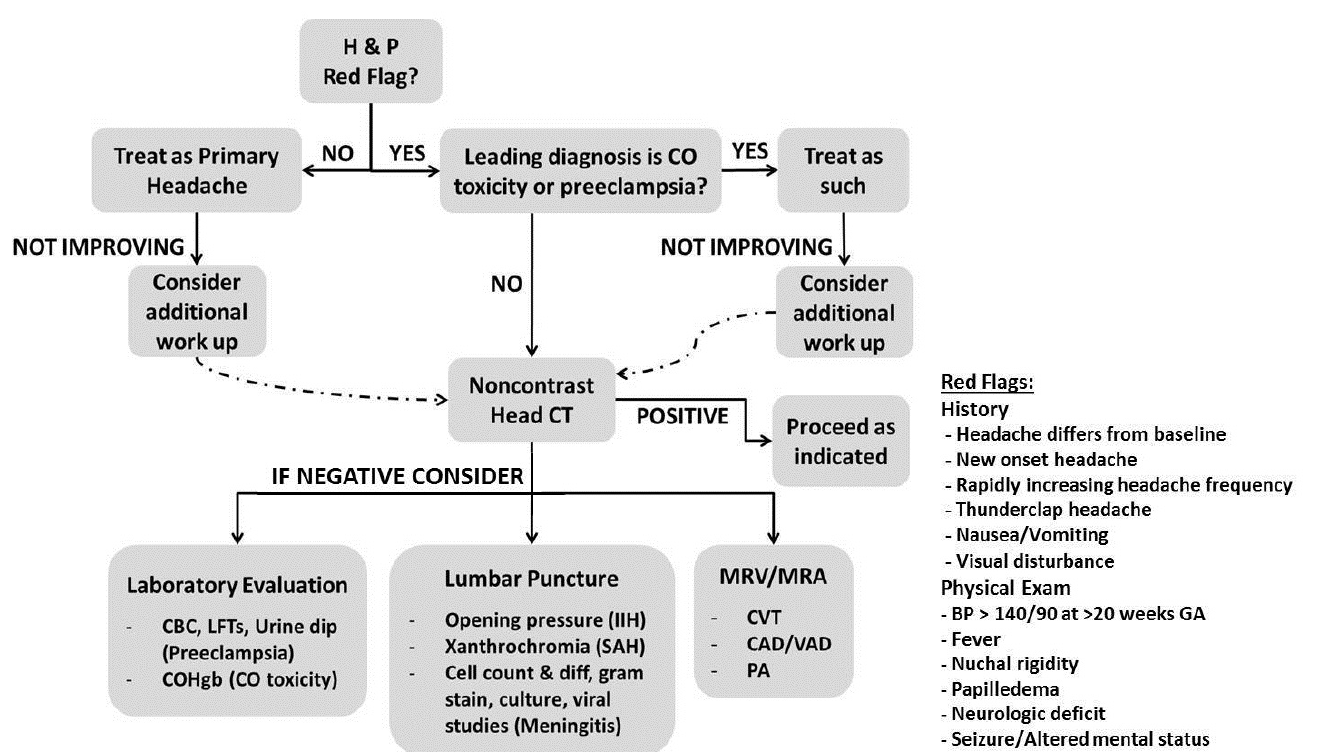
Figure. Suggested approach to evaluation of headache in a pregnant patient. Leading differential diagnosis and/or availability of advanced imaging should determine the order of laboratory evaluation, lumbar puncture, and/or MRV/MRA. Additional laboratory studies may be obtained if indicated based on differential diagnosis. H&P , history and physical; COHgb , carboxyhemoglobin; CO , carbon monoxide; CT, computed tomography; CBC, complete blood count; LFT, liver function test; IIH , idiopathic intracranial hypertension; diff , differential; SAH , subarachnoid hemorrhage; MRV, magnetic resonance venogram; MRA , magnetic resonance angiogram; CVT , cerebral venous thrombosis; CAD, carotid artery dissection; VAD, vertebral artery dissection; PA , pituitary apoplexy; BP, blood pressure; GA, gestational